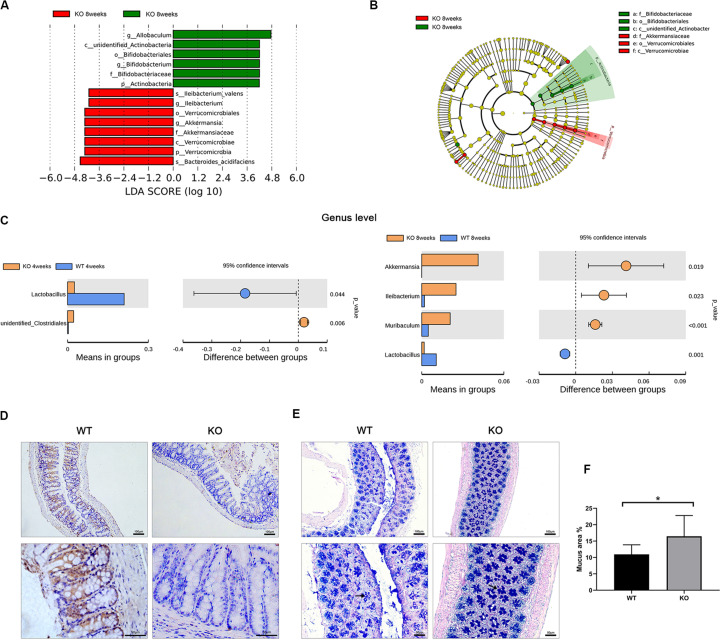
Identified specific bacteria and alterations of the gut structure in LanCL1 KO mice. (A,B) Linear discriminant analysis effect size (LEfSe) comparison of microbiota in fecal samples of mice at 8 weeks. LDA scores and cladogram generated from the LEfSe analysis, showing the bacterial taxa that were differentially abundant in LanCL1 KO mice at 8 weeks of age. (C)
T-tests were performed at the genus level to identify specific bacteria between the two types of mice at 4 and 8 weeks. (D) A representative image of LanCL1 immunostaining in the cecum of 8-week-old mice. Scale bar: upper 100 μm, lower 50 μm. (E,F) A representative image of AB-PAS staining in the cecum of 8-week-old WT and KO mice and the relative proportion of the area of mucus. Scale bar: upper 100 μm, lower 50 μm. Significant differences (P < 0.05) were determined by LEfSe analysis by both the Kruskal Wallis test (among classes) and the Wilcoxon test (between subclasses) for (A,B). The threshold logarithmic LDA score was 4.0. A significant difference (P < 0.05) was determined by unpaired two-tailed Student’s t-test for (C,F). For A through (C), n = 6/group. For (D) through (F), n = 3–4/group.